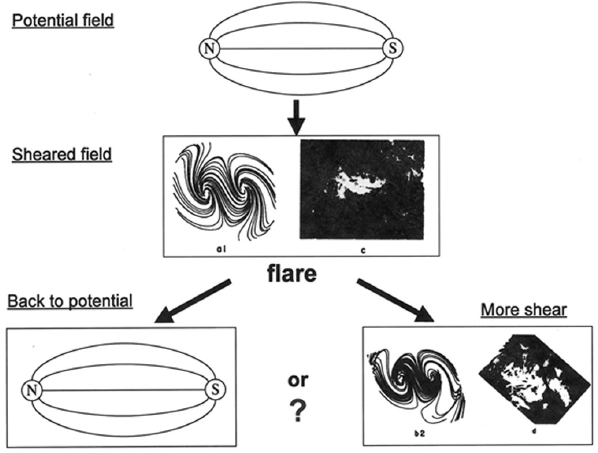
Fig. 19. Schematic illustration of two possibilities, depending on how magnetic energy changes during a flare.